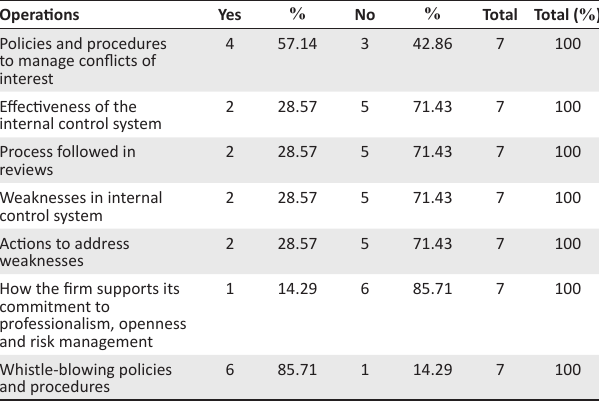
TABLE 5: Findings on the operations principle. Operations